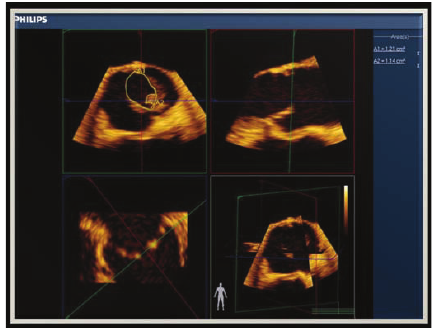
Figure 1: TEE 3D image (Philips Qlab) of the aortic valve using the planimetry method to measure the aortic valve area. TEE = Transesophageal echocardiography.